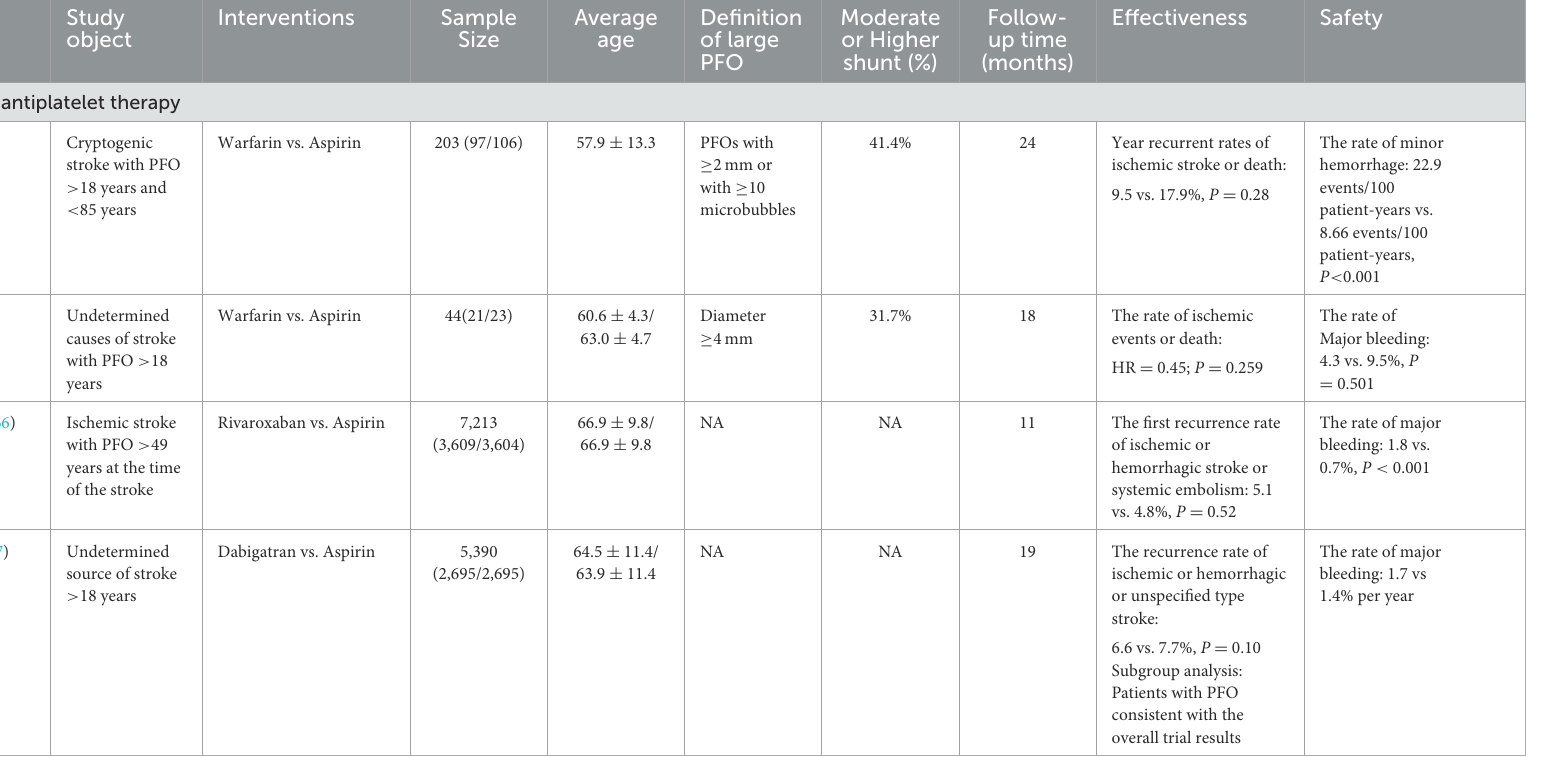
TABLE 2 Summary of important information from randomized controlled clinical trials for the treatment of PFO-related